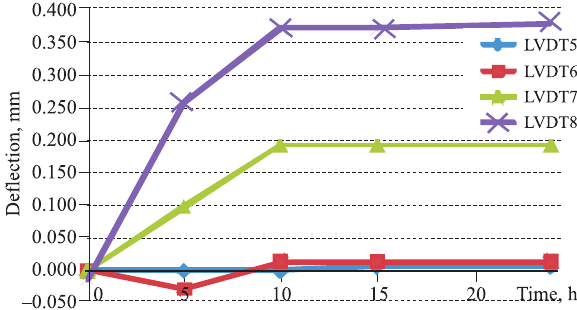
Fig. 15. Effect of scour depth on pile deflection